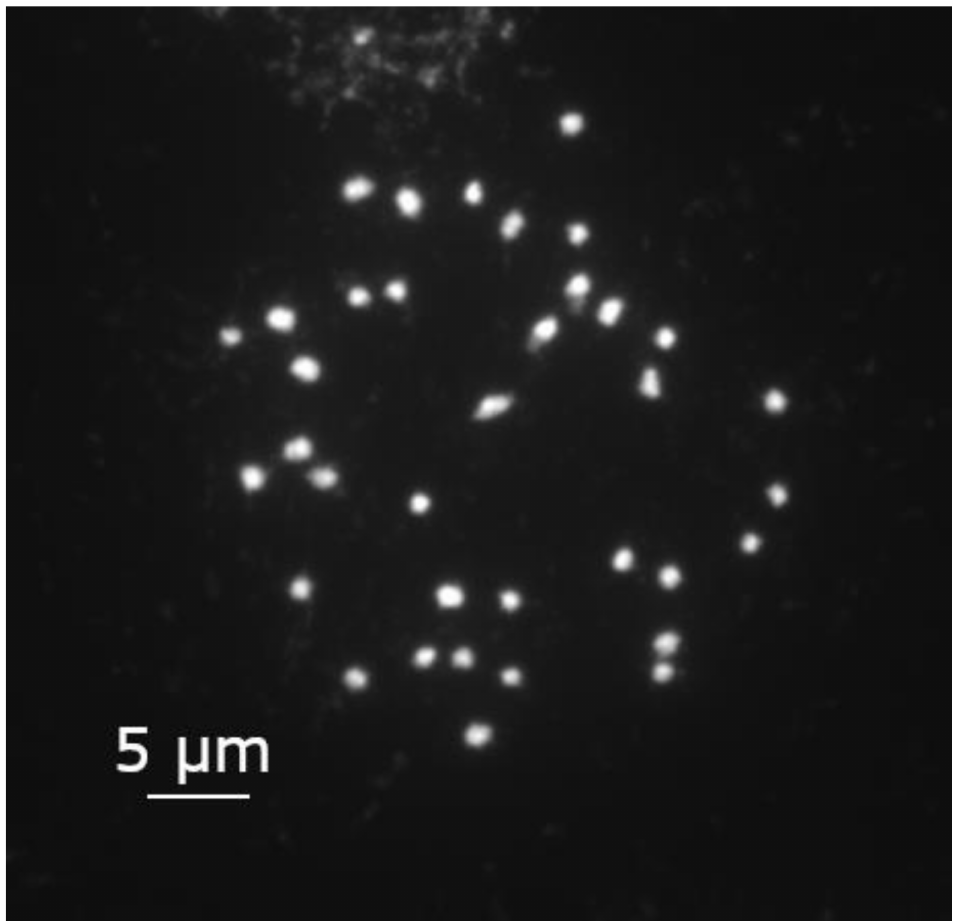
Figure 4. Mitotic metaphase chromosomes of Cyperus fuscus from the dam reservoir Vodn á n á drž Horn á Studen á voda NW of Tomky, Slovakia (2 n = 36; P. K ú r, K. Tremetsberger,